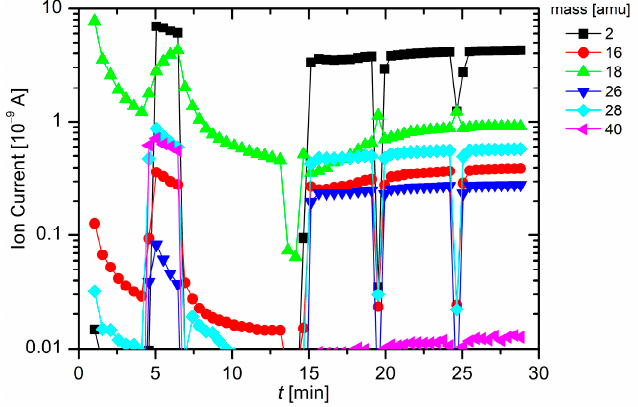
Figure 4. Mass spectrometry of gaseous molecules during all phases of the production process.